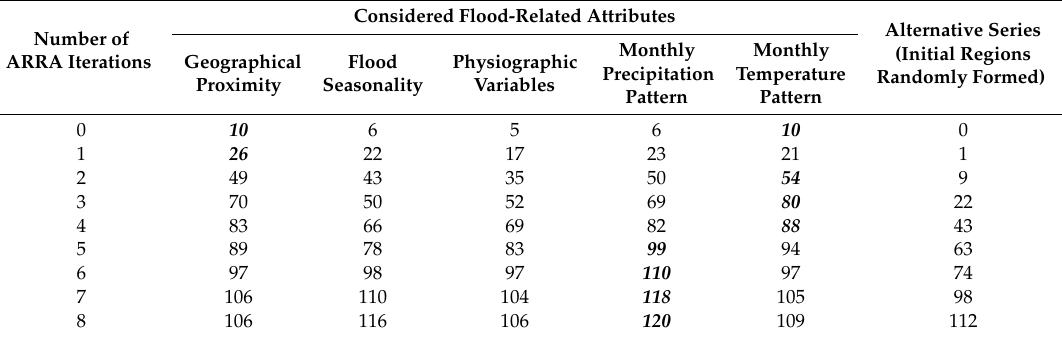
Alternative Series (Initial Regions Randomly